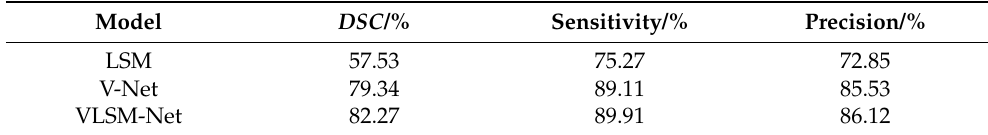
Table 2. Results of the different algorithm models in LUNA16.